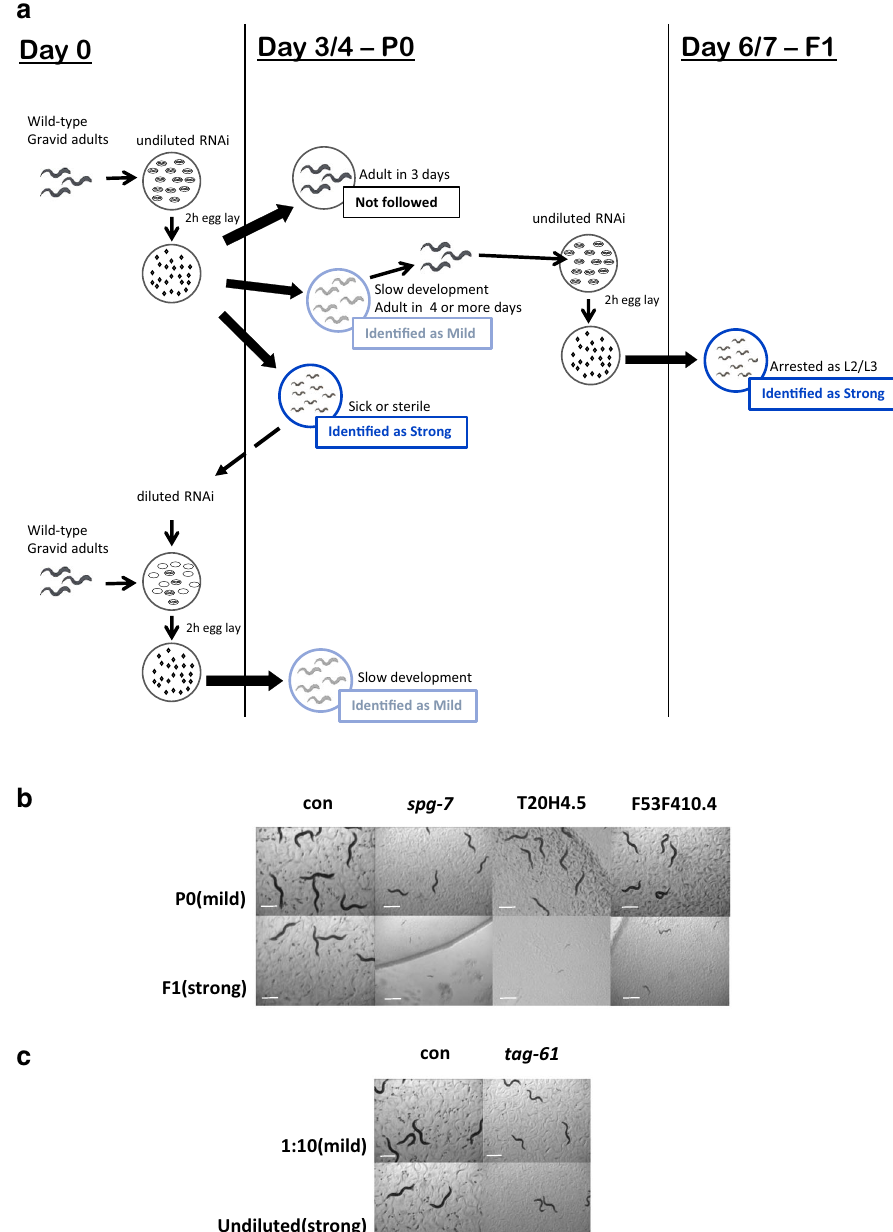
Fig. 1 Phenotypic screening to identify C. elegans models for human mitochondrial-associated disorders. a At Day 0 animals were allowed to lay eggs on undiluted bacteria expressing dsRNA for each clone under study. Progeny development was observed for the following 3/4 days (P0 or parental generation). Three possible scenarios were then identi fi ed for the different RNAi clones. (i) No effect (black): worms reached adulthood in 3 days